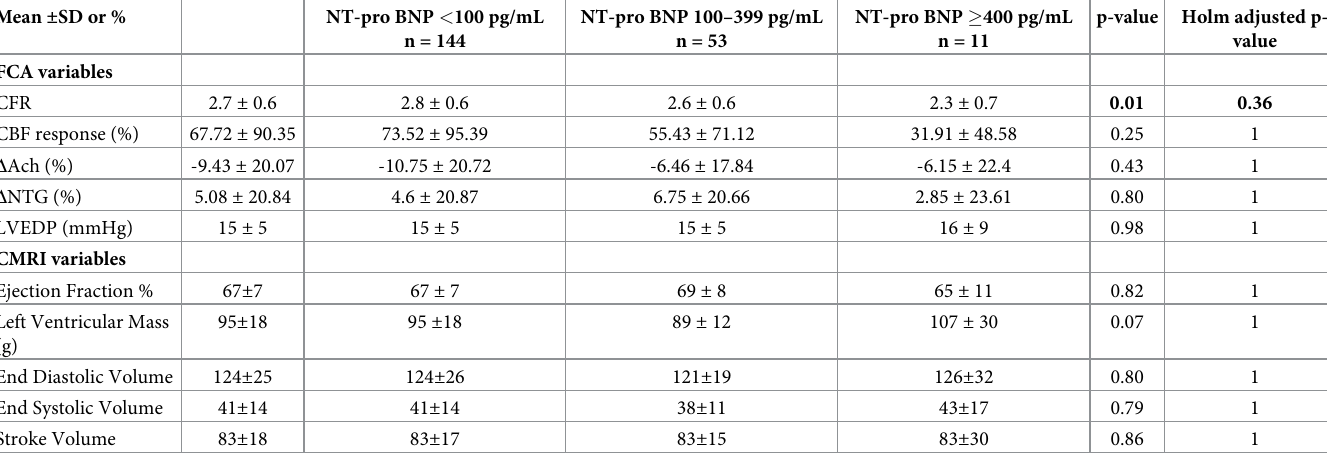
Table 2. CMRI and CMD variables by NT-proBNP groups (n = 208).